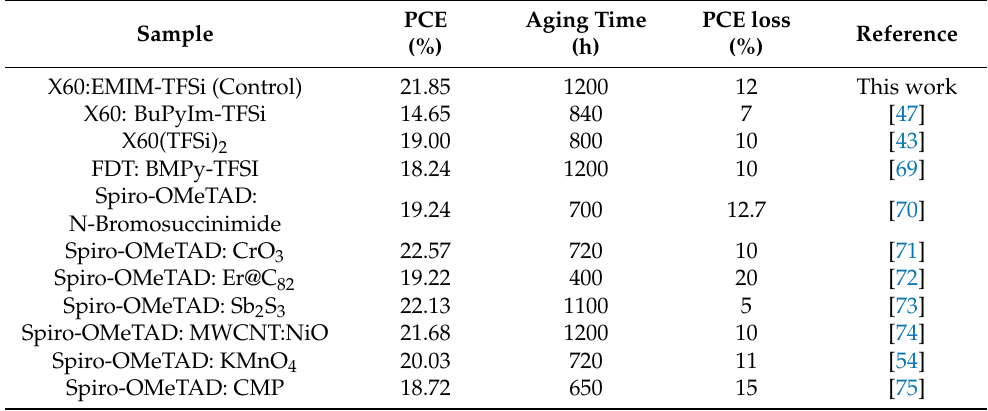
Table 3. Comparison table of PCE and long-term stability of normal PSCs incorporating Li-free dopants. The aging time is the duration of the lifetime measurements. PCE Loss stands for the percentage of PCE reduction at the end of the aging